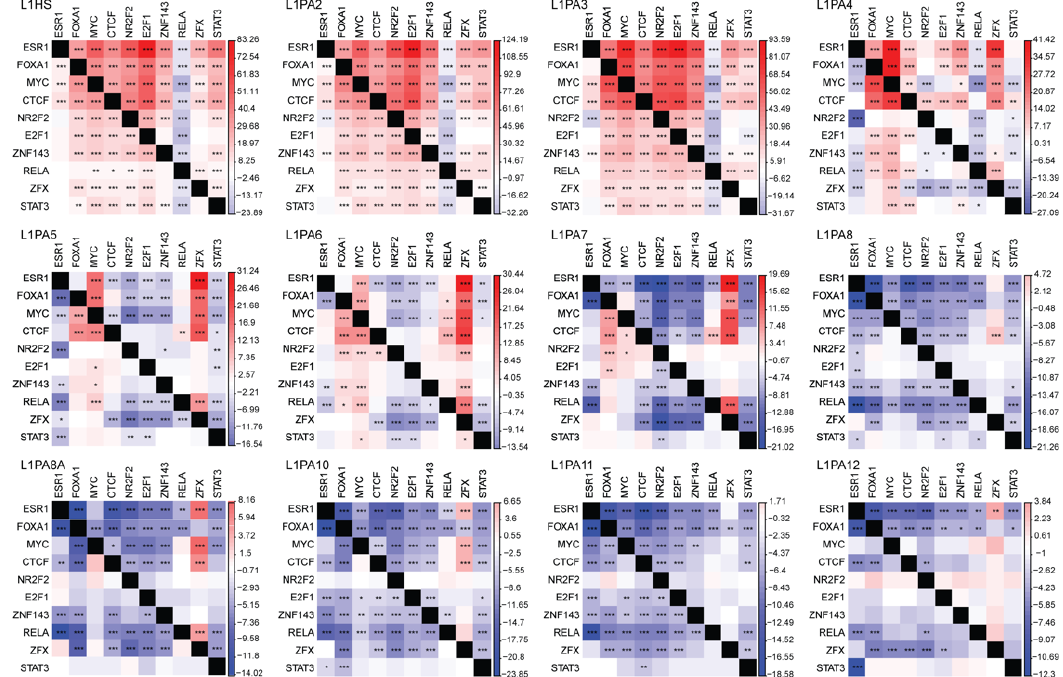
Figure 6 . Young primate-specific L1 subfamilies contributed to TFBS co-localisation in MCF7 cells. The frequency of binding site co-localisation for frequently binding TFs was compared between L1 transposons and the rest of the genome (L1 versus non-L1) using a one-tailed proportion z-test. The heatmap indicates the z-scores of the proportion tests, where a positive z-score (red) indicates more co-localisation in L1, and a negative z-score (blue) indicates depletion of binding site co-localisation in L1. p < 0.0005: *; p < 0.0001: **; p < 0.00001: ***. The z-scores correspond to the frequency of the TF in the row co-localising with the TF in the column .